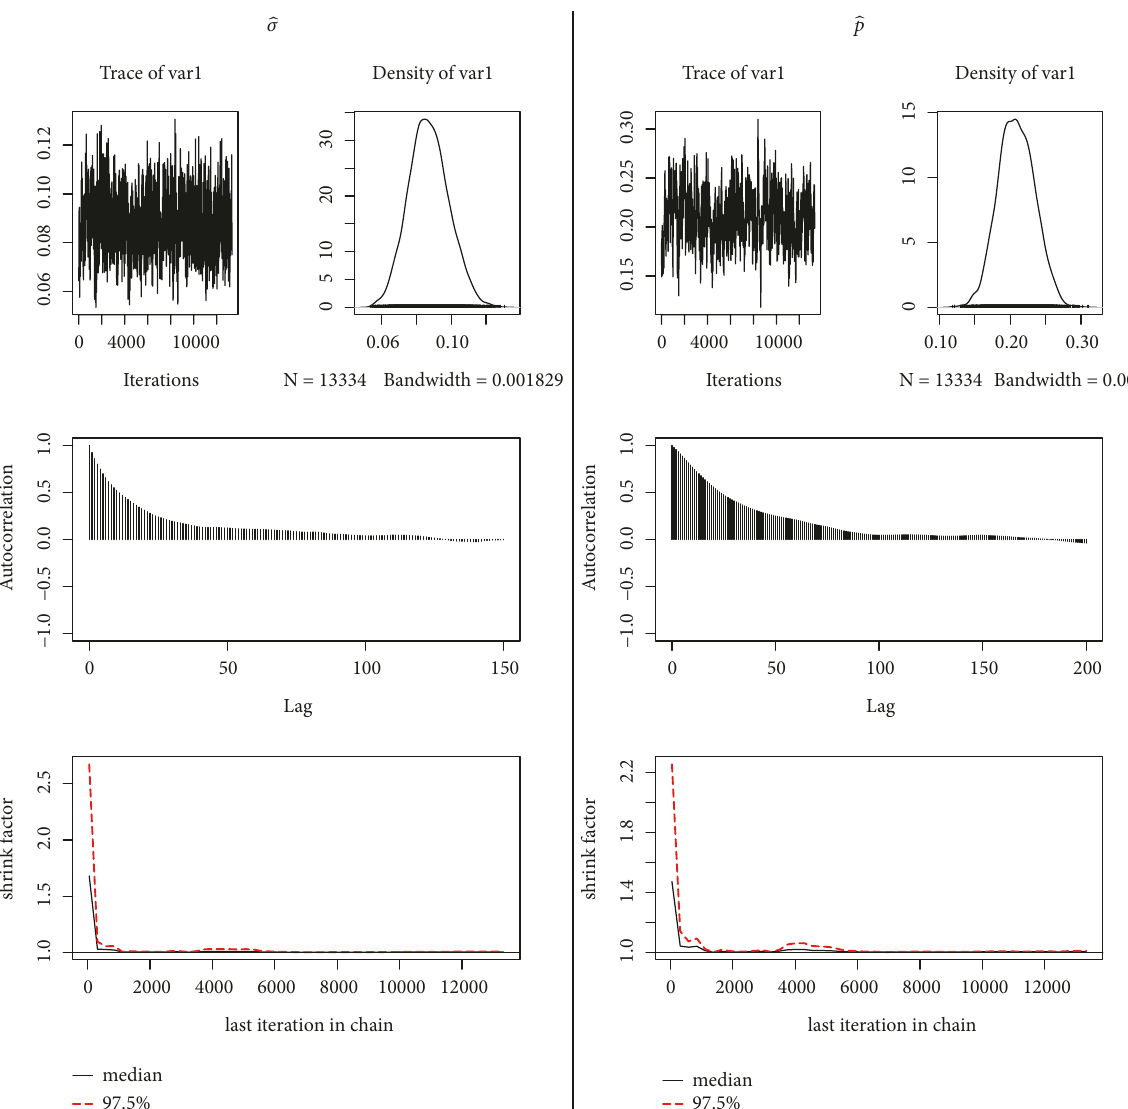
̂𝑅 evolution through iterations (bottom) of ̂𝜎 (left panel) and ̂𝑝